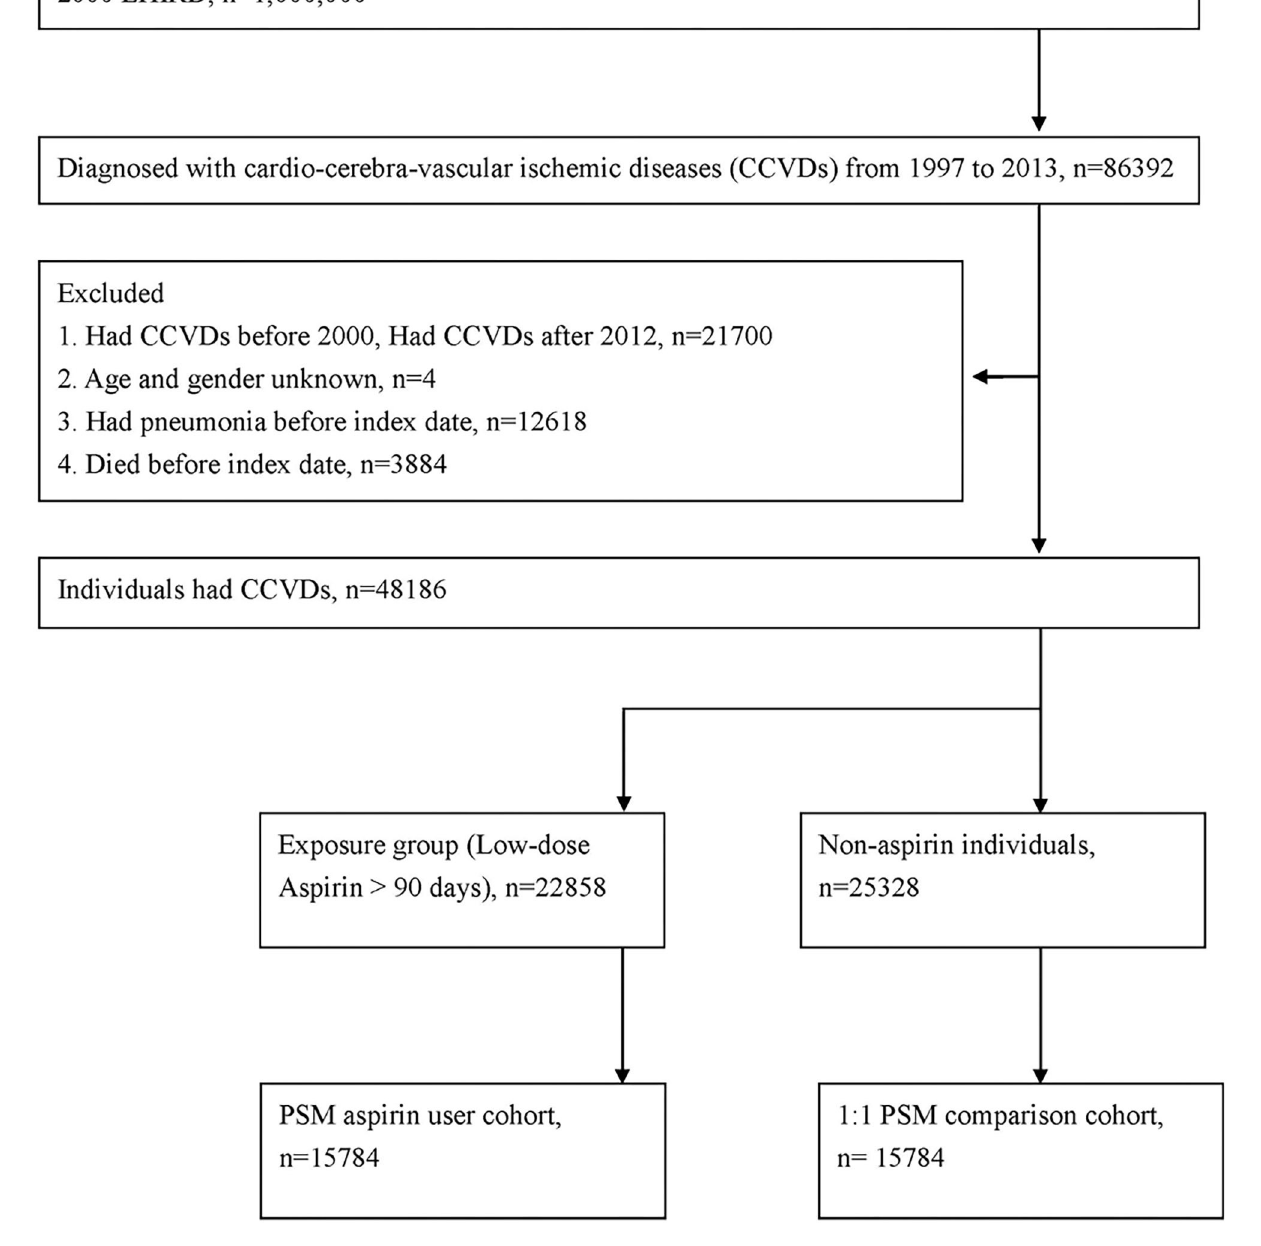
FIGURE 1 | Flowchart of patient